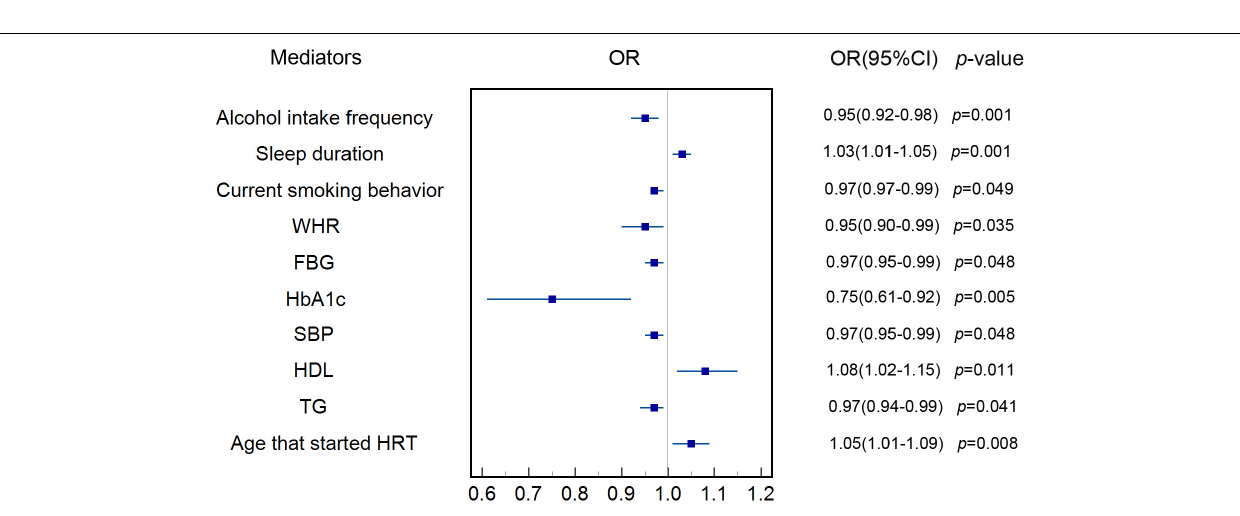
FIGURE 2 | Estimate of the association of genetically predicted AAM with each genetically determined potential mediator. IVW was applied as main analysis. The results showed that increase in genetically predicted AAM was associated with genetically determined longer sleep duration, higher levels of HDL and older at which HRT was started. The results also showed that increase in genetically predicted AAM was inversely associated genetically determined alcohol intake frequency, current smoking behavior, WHR, FBG, HbA1c, SBP, and TGs. AAM, age at menarche; IVW, inverse variance weighted; HDL, high-density lipoprotein; HRT, hormone replacement therapy; WHR, waist-hip-ratio; FBG, fasting blood glucose; HbA1c, hemoglobin A1c; SBP, systolic blood pressure; TG,